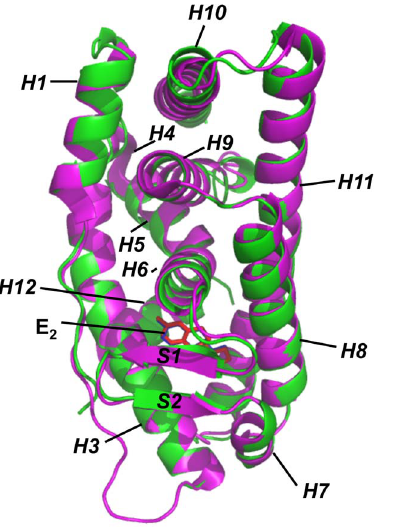
Figure 2. The overlay of the ligand-binding domains (LBDs) of ER a and ER b . The protein structures were shown in cartoon and colored green and magenta for ER a and ER b , respectively. E 2 molecules were shown in stick and colored blue and red in ER a and ER b LBD, respectively. a -Helixes and b -sheets in the ER LBDs are labeled according to references [14,16]. Helix 2 structures are missing in both X -ray structures. doi:10.1371/journal.pone.0074615.g002 PLOS ONE |